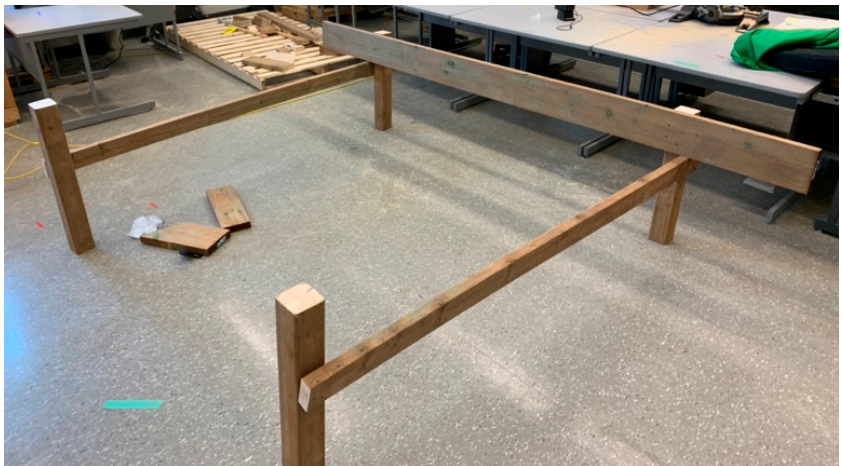
Figure 2. The 2 × 8 beam installed between the back posts, with temporary 2 × 4 lateral bracing installed between the left and right posts.